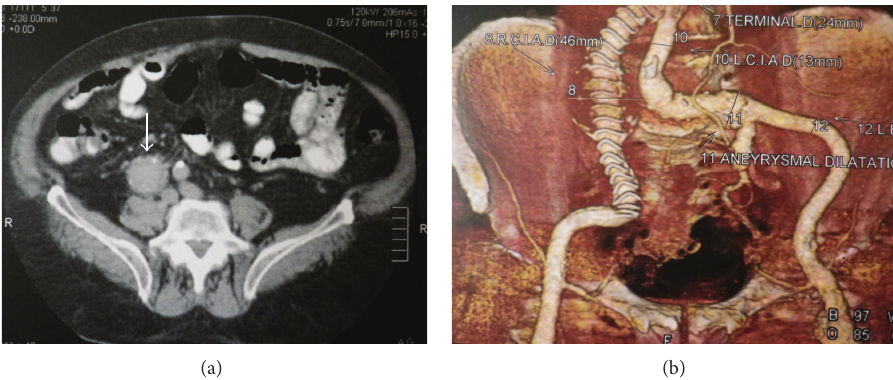
Figure 1: (a) Preoperative contrast-enhanced abdominal CT showing severe aneurysm of the RCIA with diameter 4.5×4.7 cm. (b) Contrast- enhanced CT scan reconstruction at 18 months showing patency of the endograft, complete aneurysm exclusion without any endoleak.